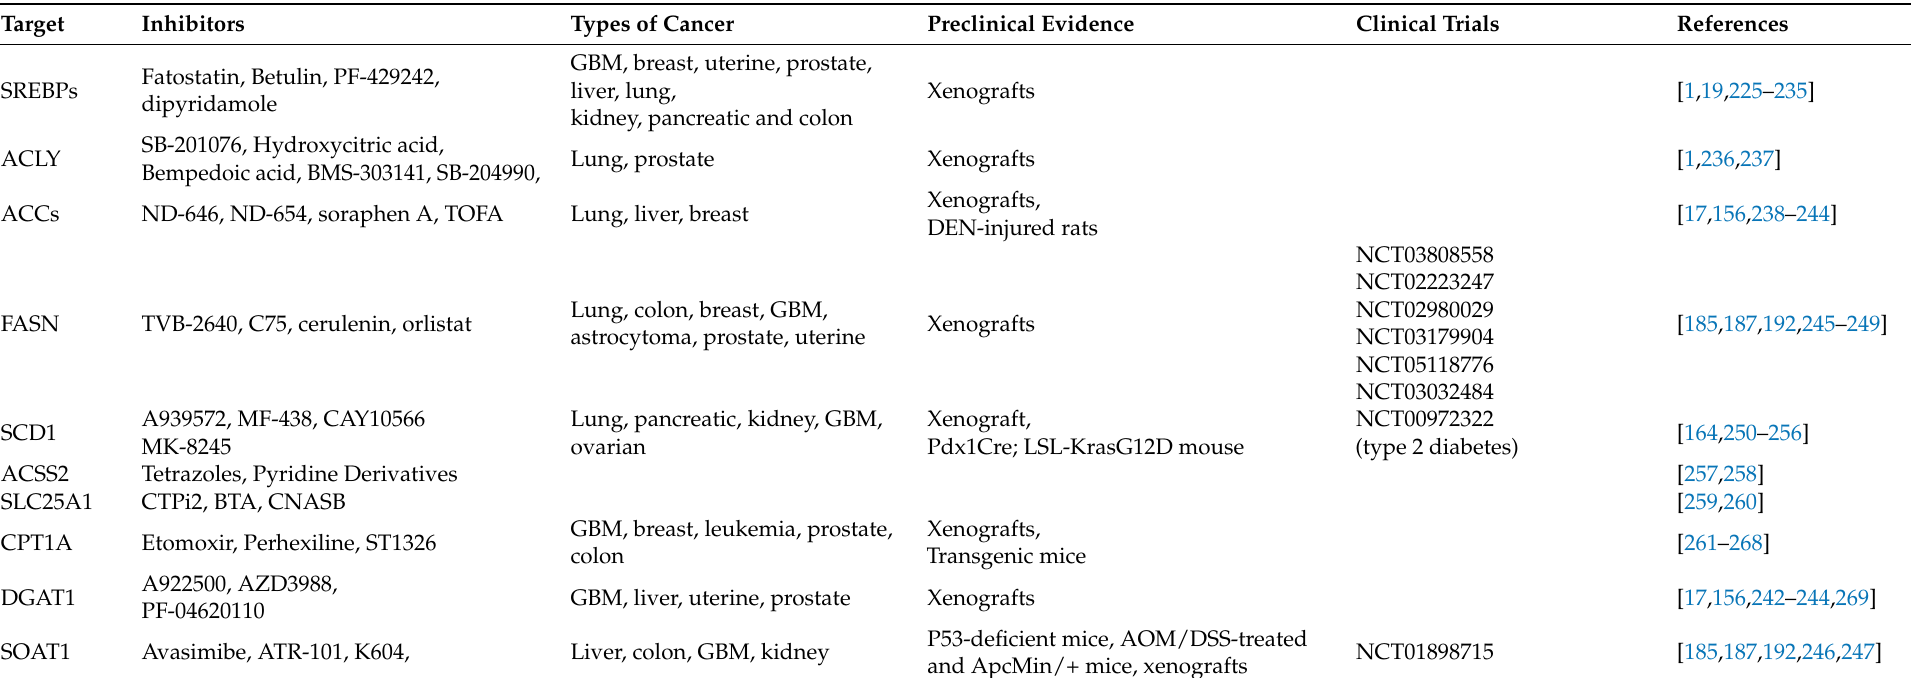
Table 1. Molecular targets and inhibitors in the lipid metabolism pathway for cancer